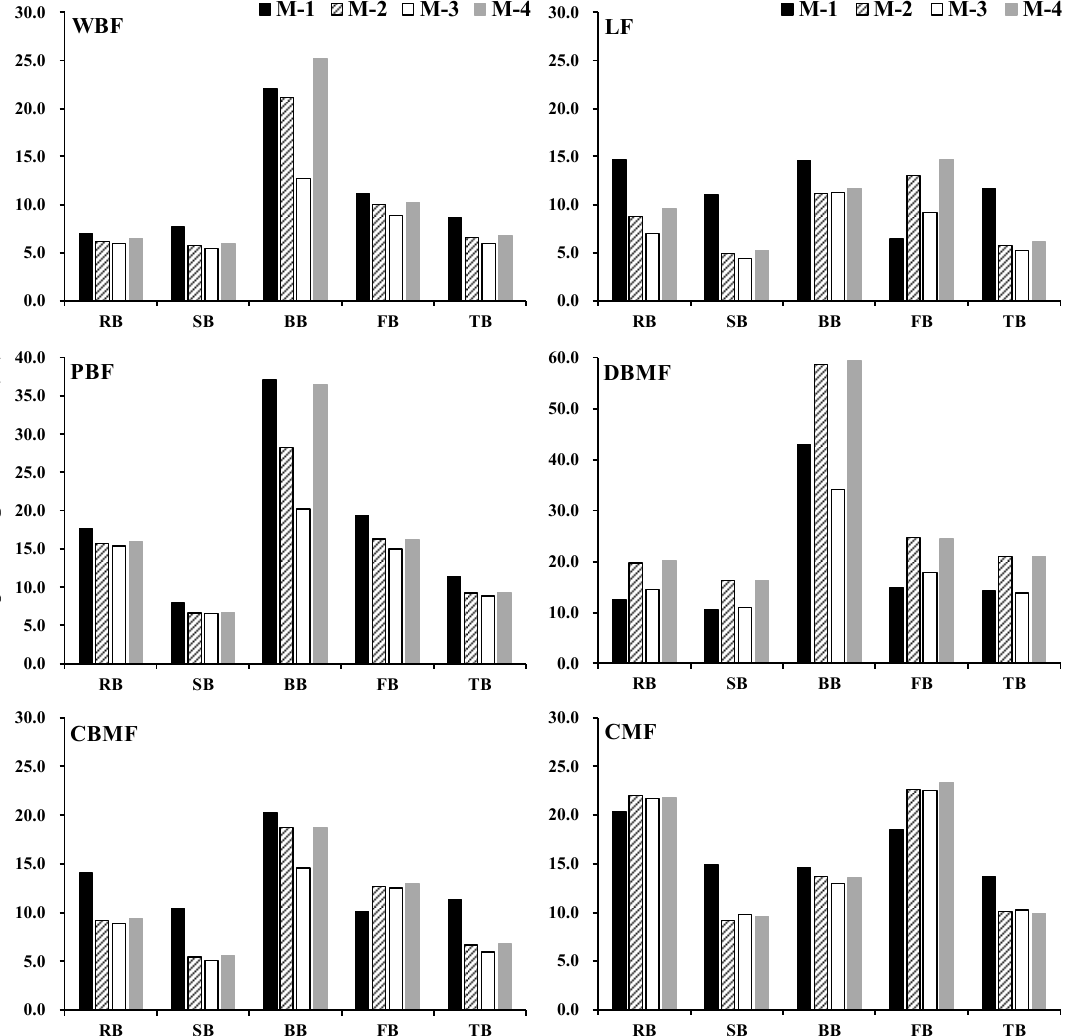
Figure 4. The mean percentage differences of the four methods used to estimate stand biomass for each forest type. WBF, LF, PBF, DBMF, CBMF and CMF stand for white birch forest, larch forest, poplar-birch forest, deciduous broadleaf mixed forest, coniferous and broadleaf mixed forest and coniferous mixed forest, respectively. TB, RB, SB, BB and FB represent the total, root, stem, branch and foliage biomass, respectively.